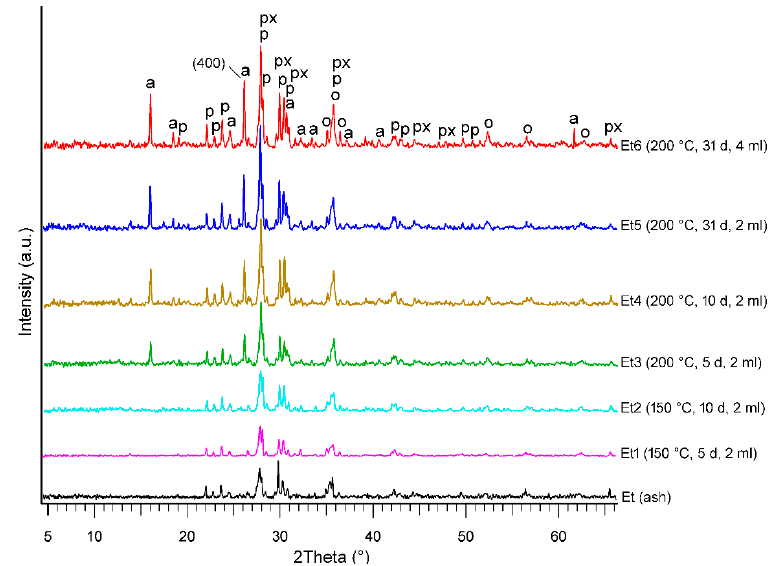
Figure 5. XRPD pattern from the starting material (Et) and products (Runs Et1–Et6). a = analcime; O = olivine; p = plagioclase; px = pyroxene. Peaks were assigned according to the literature.